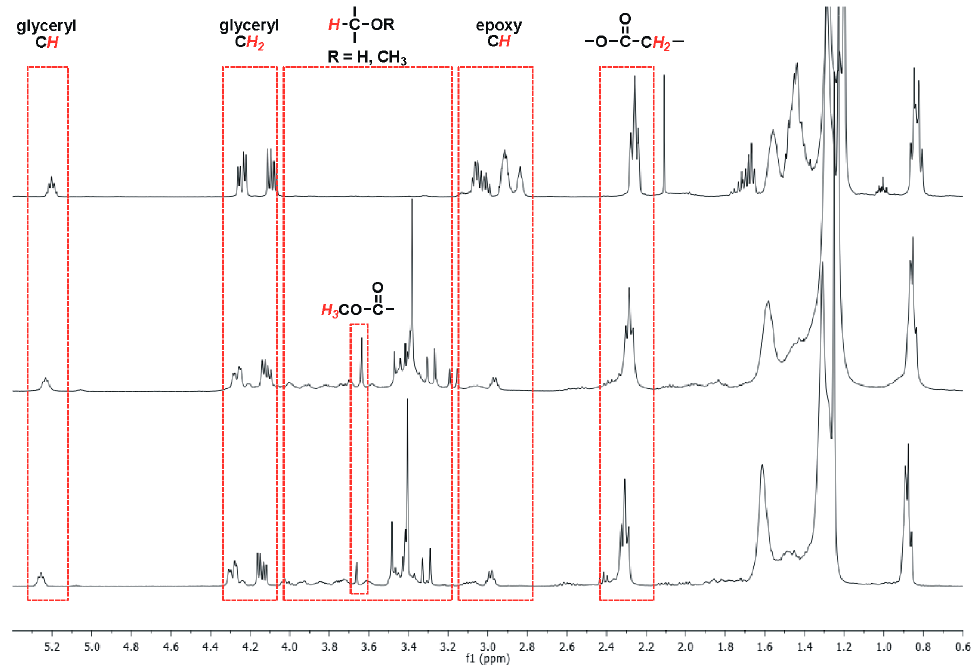
Figure 3. 1 H-NMR (CDCl 3 , 400 MHz) spectrum of ( a ) ESO; ( b ) bio-polyol 1 from HBF 4 -catalyzed methanolysis of ESO at 2 h, and ( c ) from MoCl 2 O 2 -catalyzed methanolysis of ESO at 2 h.